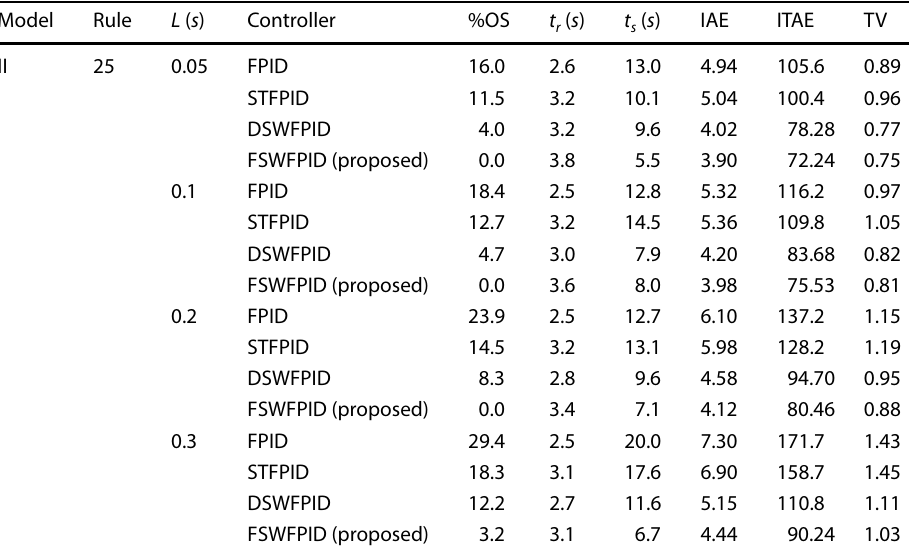
Table 8 Performance analysis for Model II